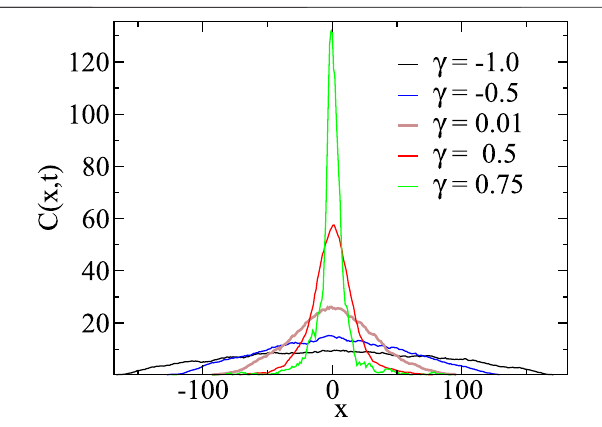
FIGURE 2 | Concentration resulting from an initial δ -pro fi le as a function of position for negative and positive γ -values after a time t (cid:2) 50. For c ≤ 0 . 5 and a running average over a window of 20 data points was applied, for c (cid:2) 0 . 75the running average was over 5 data points. In all cases D 0 (cid:2) 1 (in units of the lattice constant 2 /timestep) , N p (cid:2) 2,000 and dt (cid:2) 10 − 4